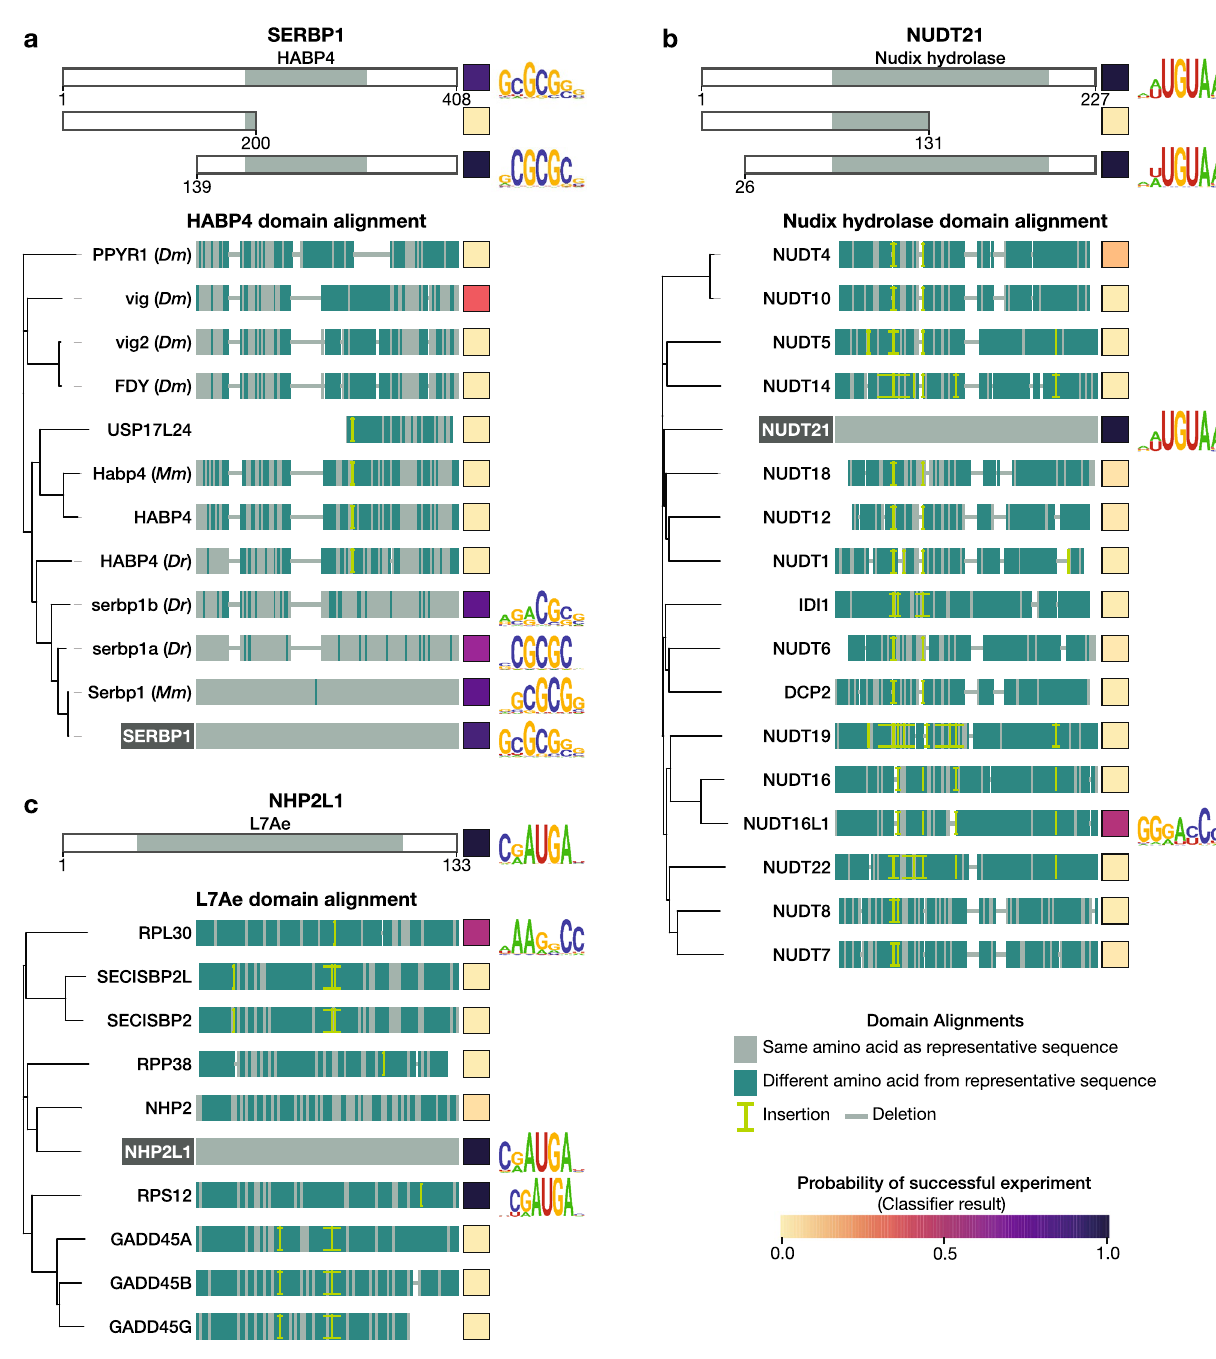
Figure 3. RNA-binding specificity of putative ucRBDs (Part I). Representative ucRBPs identified in this study for selected ucRBDs—( a ) HABP4, ( b ) Nudix hydrolase, and ( c ) L7Ae—are shown at the top. Below these are depictions of deletion constructs used to identify corresponding ucRBDs with sequence-specific RNA-binding. ucRBPs listed below the ucRBD “domain alignment” heading depict ucRBD-only constructs analyzed by RNAcompete. Amino acid differences between the representative and test ucRBDs, as analyzed by COBALT 83 , are indicated. Clustal Omega 82 was used to generate phylogenetic trees; visualizations were created with iTOL 88 . Square boxes to the right of each construct display the classifier score indicating the probability of a successful RNAcompete experiment. Logos are provided for ucRBPs/ucRBDs with sequence-specific RNA-binding motifs. Mm , Mus musculus ; Dr , Danio rerio ; Dm , Drosophila melanogaster